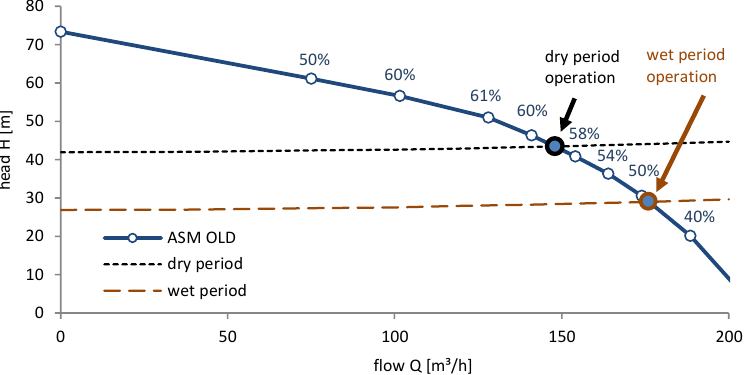
Figure 5. System curves for the dry period and the wet period, and the ASM pump curve with global efficiency information vs flow, and the working points for the dry period and the wet period.